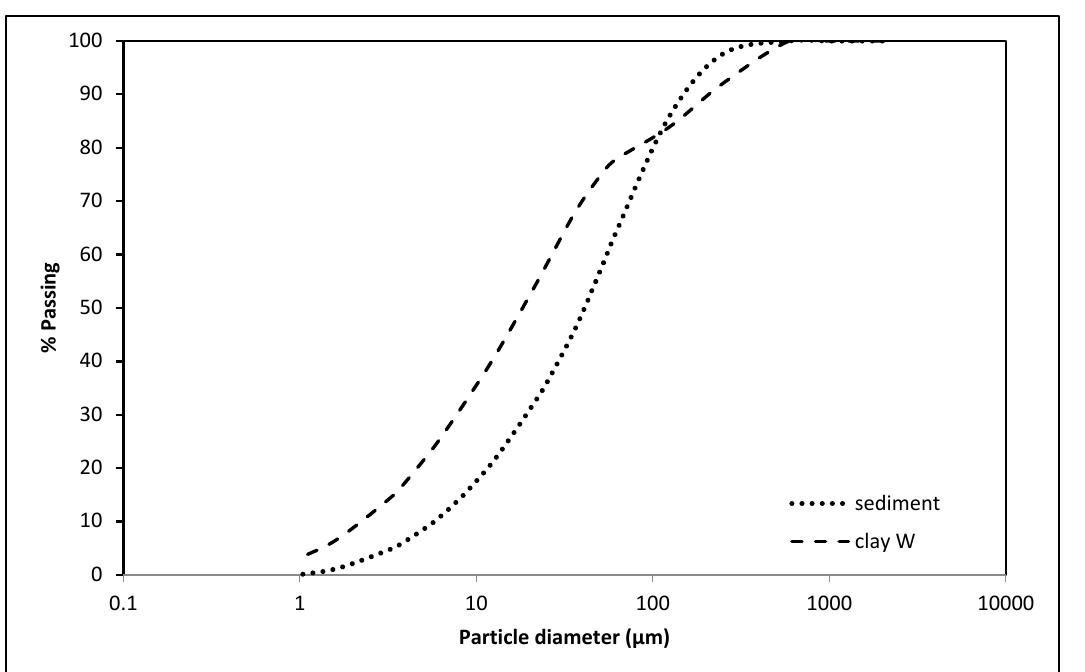
Figure 4. Particle size distribution of the W clay and sediment from Lake Ptuj 10.